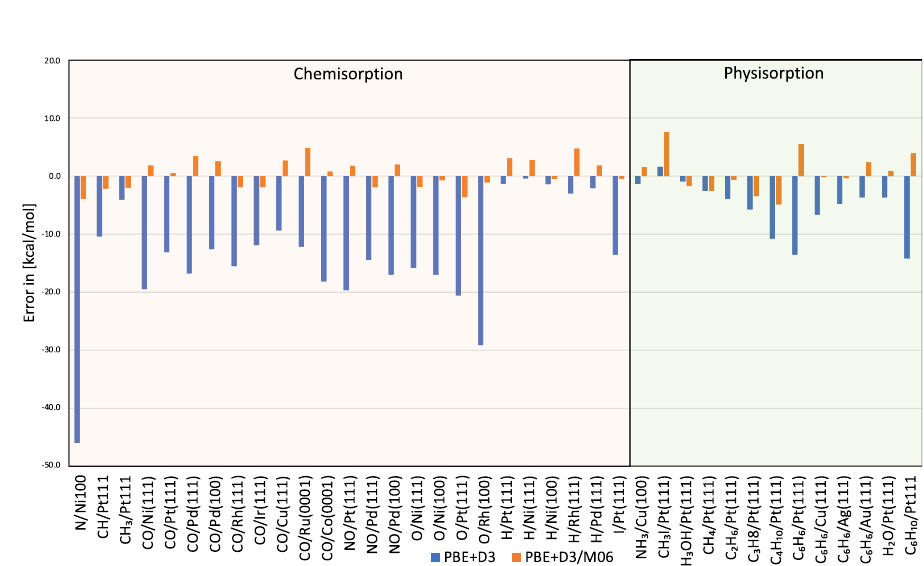
Fig. 2 | Adsorption energy errors before and after cluster correction. Error comparison between adsorption energies using PBE+D3 (blue) and the corrected values based on our approach(orange).Systems to the left (N/Ni(100) to I/Pt(111)) arecharacterizedaschemisorption(lightpurplebackground fi ll)whilesystemson